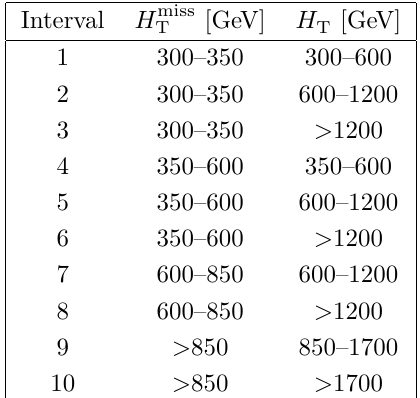
Table 1 . De(cid:12)nition of the search intervals in the H miss discarded for N (cid:21) 8. In addition, regions with H miss jet